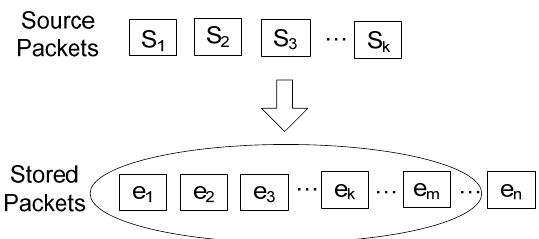
Figure 3. The distributed storage